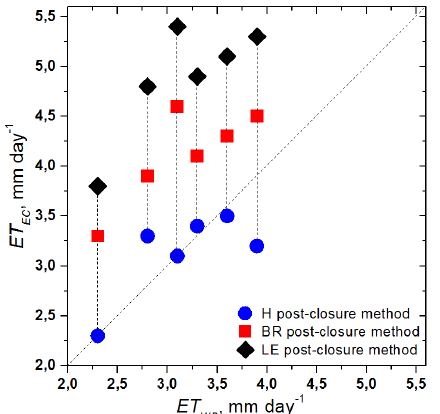
Figure 9. Scatter plots between evapotranspiration assessed from the soil water balance, ET WB , and evapotranspiration measured by the eddy covariance technique, ET EC , adjusted by the sensible heat flux ( H ), the Bowen ratio (BR) and the latent heat flux (LE) post- closure